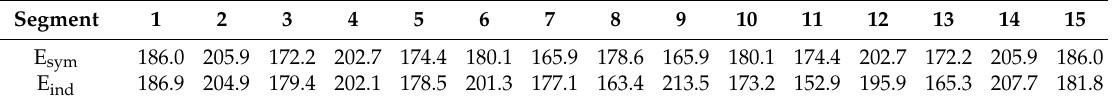
Table 2. Optimal elastic modulus of the intact portal frame (GPa).